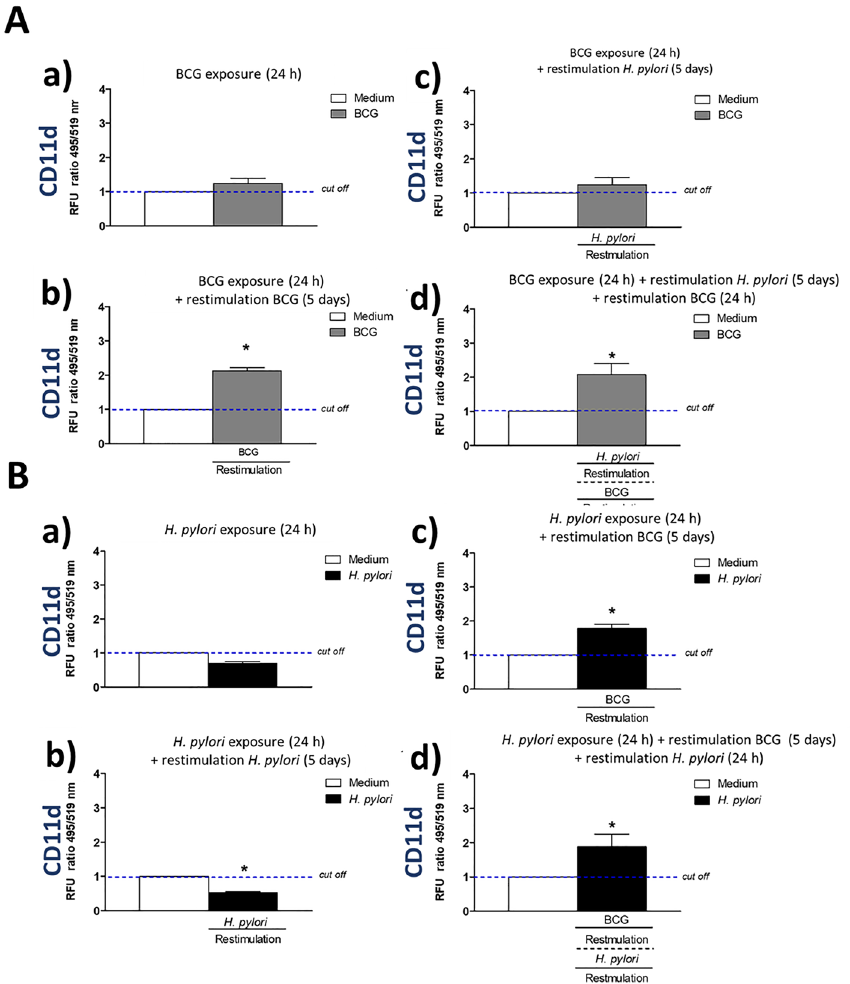
Figure 4. Positive modulation of CD11d expression in THP-1 macrophages by M. bovis BCG. Cells were primed with M. bovis BCG or H. pylori and then underwent restimulation with homologous or heterologous microbial agent. THP-1 macrophages primed with M. bovis BCG ( A ): cells primed for 24 h with M. bovis BCG (a); cells primed for 24 h with M. bovis BCG and restimulated for 5 days with M. bovis BCG (b); cells primed for 24 h with M. bovis BCG and restimulated for 5 days with H. pylori (c); cells primed for 24 h with M. bovis BCG then restimulated for 5 days with H. pylori and for an additional 24 h with M. bovis BCG (d). THP-1 macrophages primed with H. pylori ( B ): cells primed for 24 h with H. pylori (a); cells primed for 24 h with H. pylori and restimulated for 5 days with H. pylori (b); cells primed for 24 h with H. pylori and restimulated for 5 days with M. bovis BCG (c); cells primed for 24 h with H. pylori , restimulated for 5 days with M. bovis BCG and an additional 24 h with H. pylori (d). The above variants of cells were stained using the fluorescently labeled specific anti-CD11d antibodies. Results are presented as median fluorescence units (RFU) ratio ± range of three independent experiments. The difference statistically significant when p < 0.05 in Mann–Whitney U test. *Cells stimulated versus unstimulated (according to the time of stimulation). BCG or H. pylori MOI